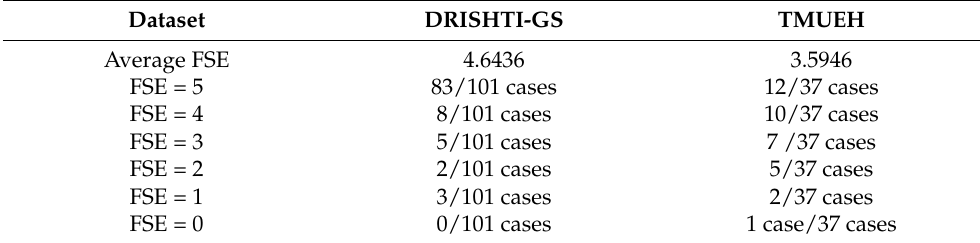
Table 5. Evaluation results with FSE.